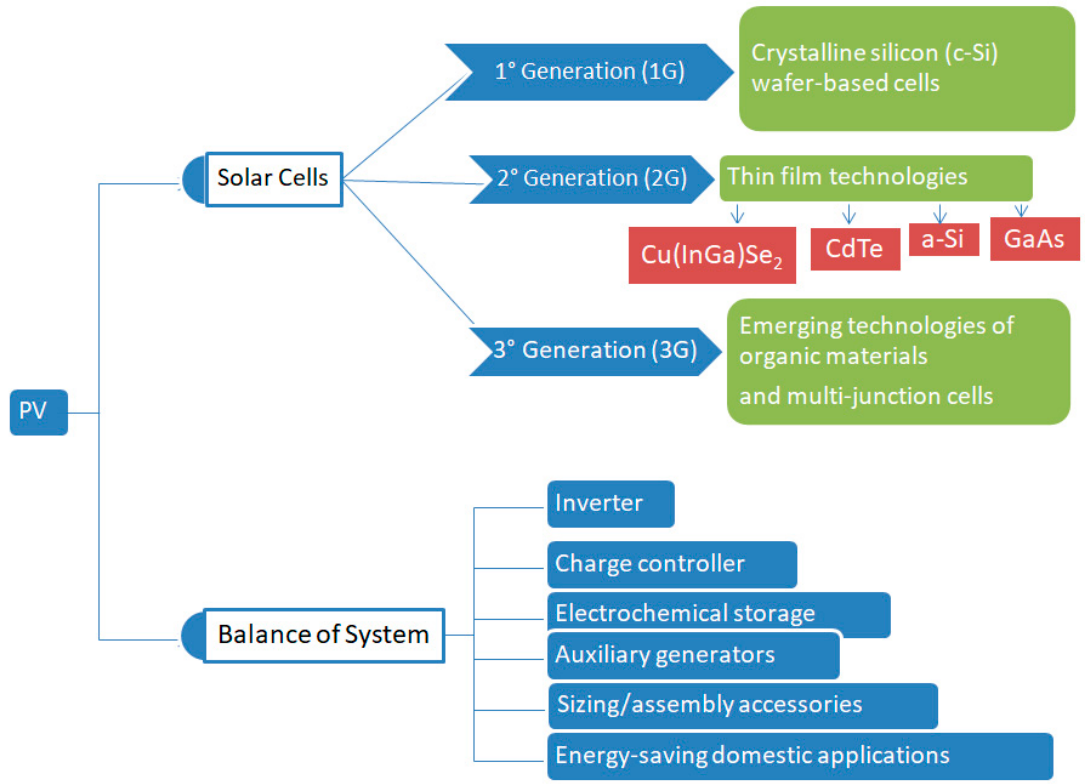
Figure 1. Photovoltaic (PV) system